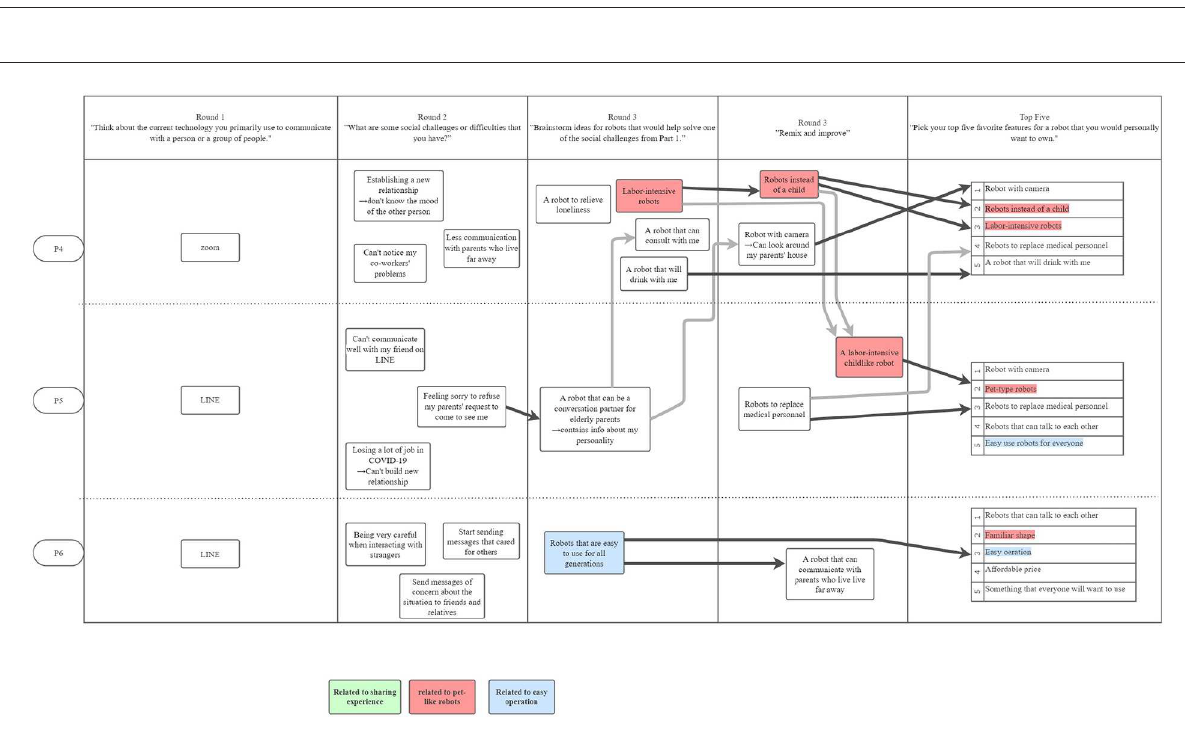
FIGURE6 The second PD session in Japan was also held on August 29, 2021 and had 3 participants. Similarly, the theme of pet-like robots arose; “easy operation” was another top theme, as indicated by participants in their “top